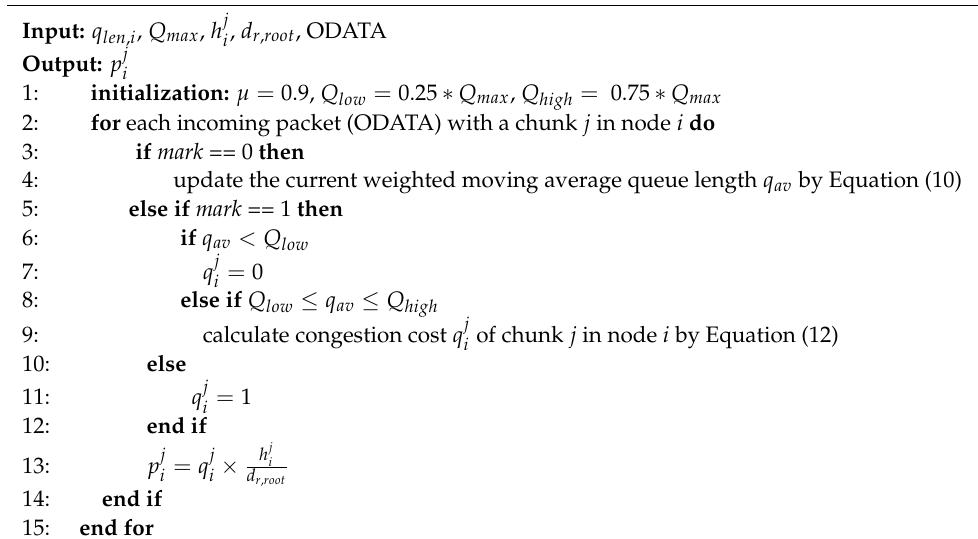
Algorithm 1 The Calculation of Cache